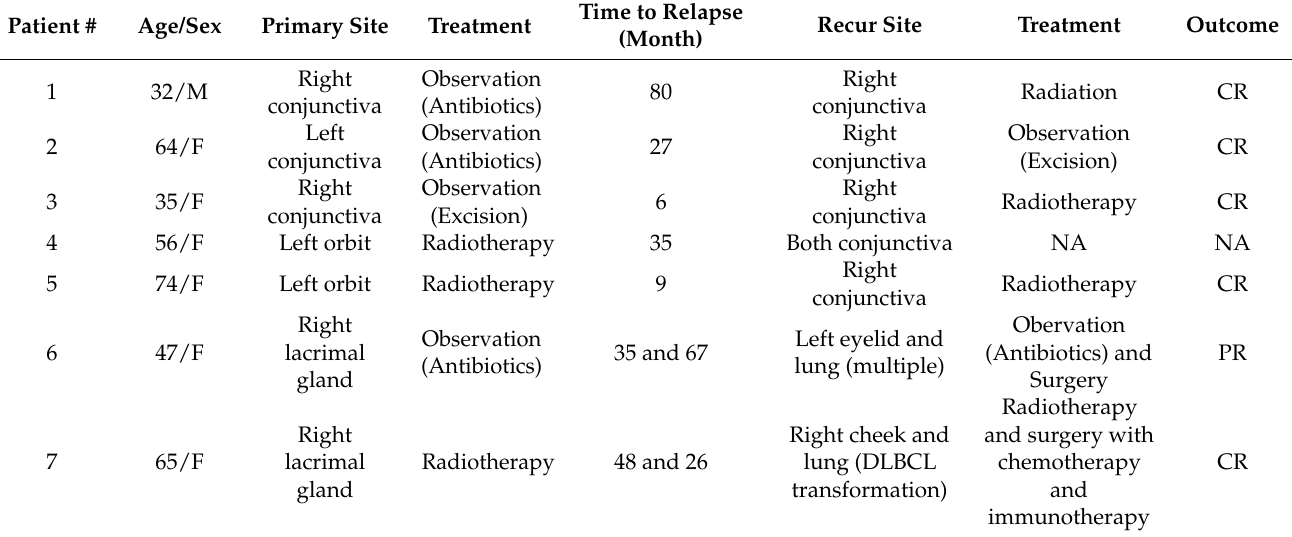
Table 5. Clinical characteristics in recurred